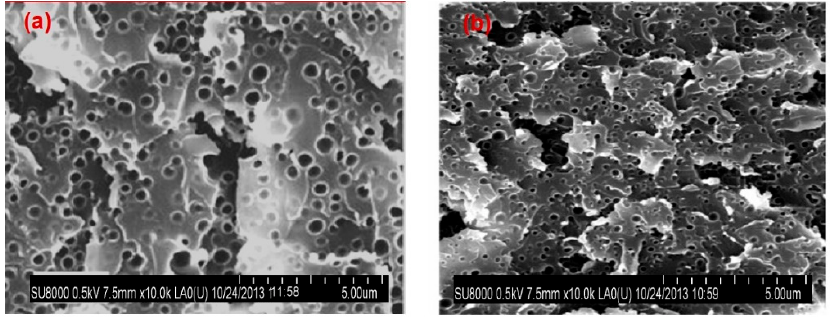
Figure 5. SEM images of ESO ( a ) and ESO/ZnO (5.0 wt %) nanocomposite ( b ). Reprinted from [17], copyright 2014, with permission from the American Chemical Society.